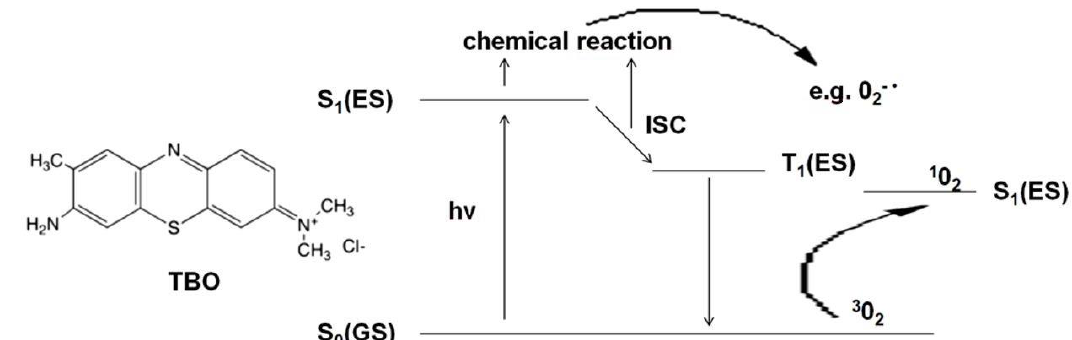
Figure 1. A simplified diagram of Jabło´nski showing the mechanism of action of aPDT. Abbreviations: S 0 (GS)—ground singlet state, S 1 (ES)—excited singlet state, hv- light quantum (photon), ICS—intersystem crossing, O 2 − • —superoxide anion, 3 0 2 - molecular oxygen, 1 0 2 - singlet oxygen.